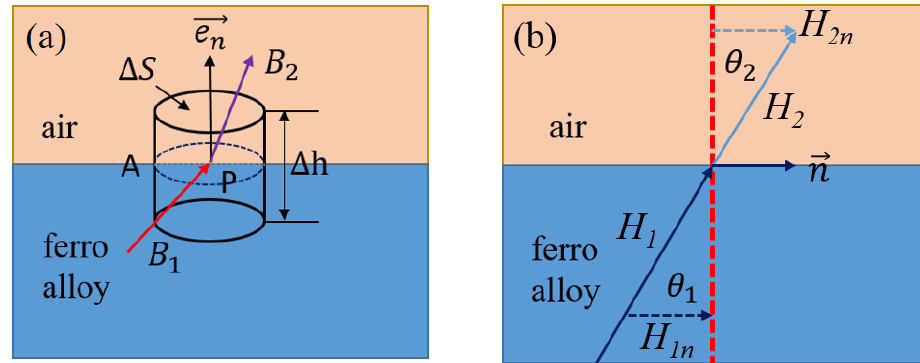
Figure 7. The model of magnetic field line propagation: ( a ) Electromagnetic boundary between two media, ( b ) Refraction relation.